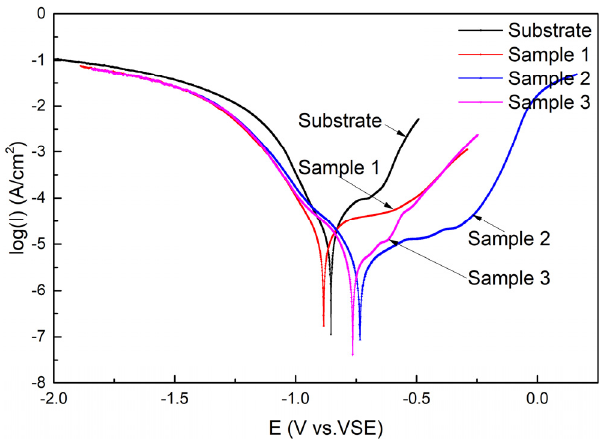
Figure 13. Polarization curves of the substrate and cermet coatings.